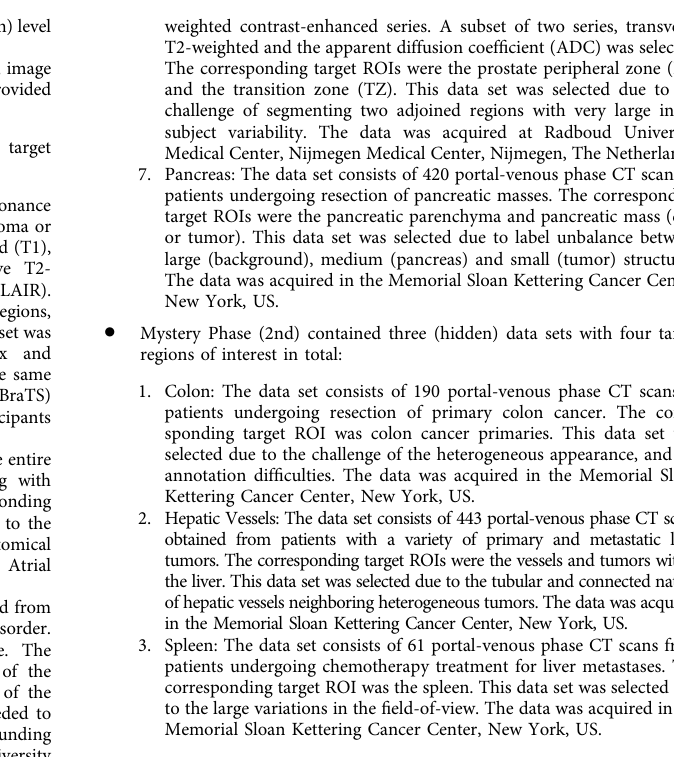
Table 2 presents a summary of the ten data sets, including the modality, image series, ROI targets and data set size. A brief description of each data set is provided below.